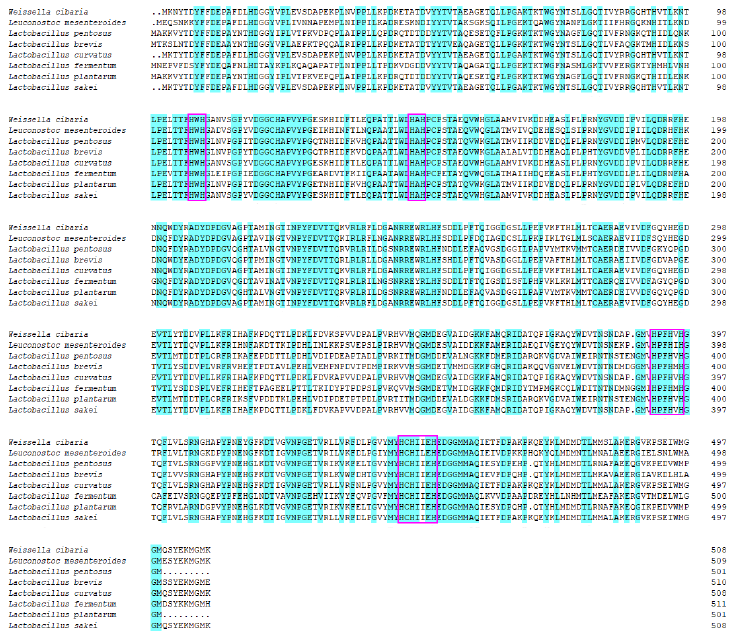
Figure 2. Amino acid sequence alignment of rMCO and other MCOs from different LAB species. Identical amino acids are highlighted in solid blue. Encased inside boxes represent the highly conserved motifs forming four copper ligands in MCOs.